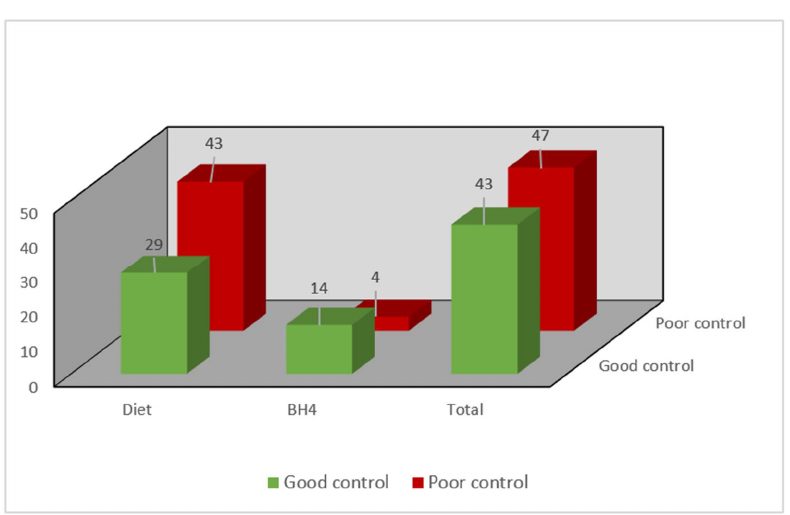
Figure 2. Number of patients ( n ) according to metabolic control. BH4: tetrahydro-biopterin.